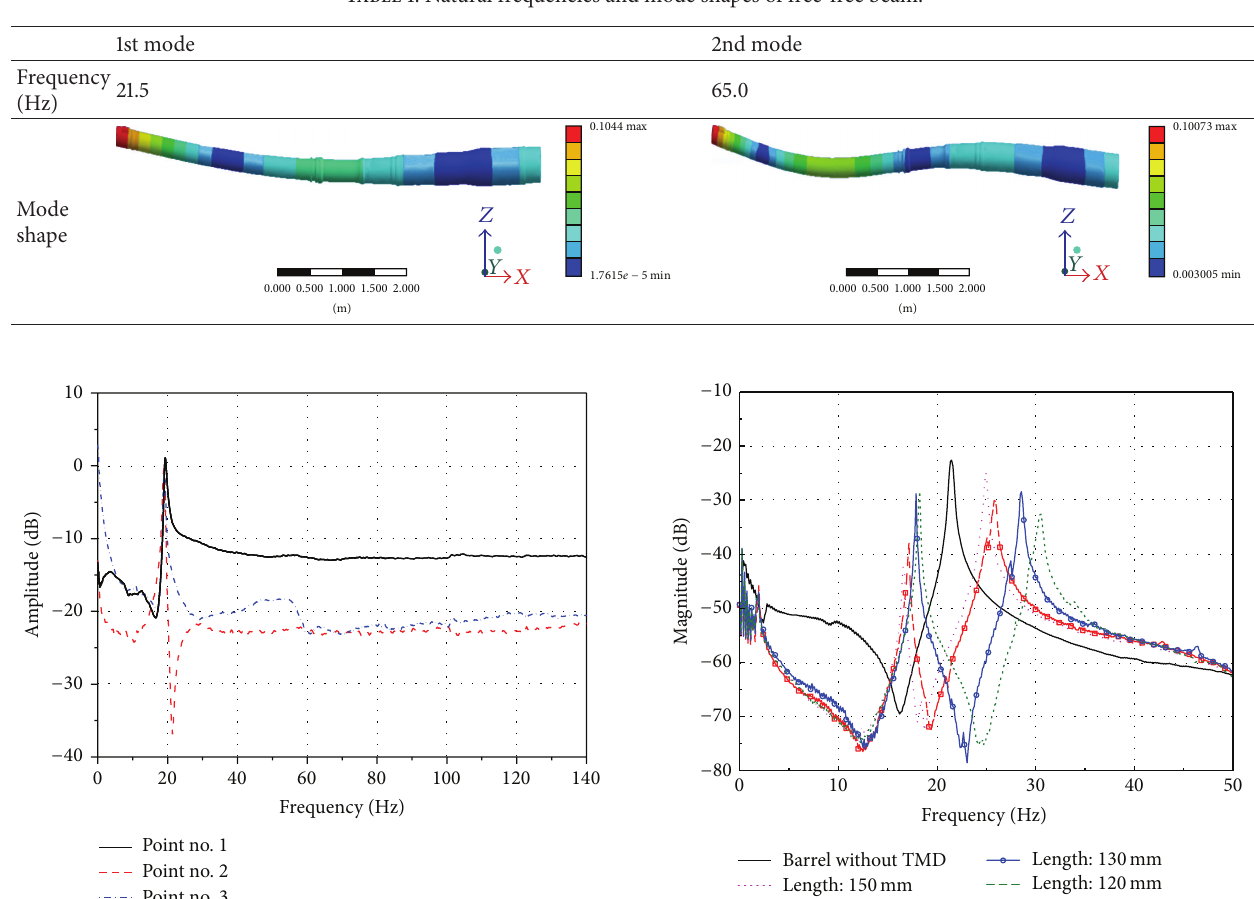
Table 1: Natural frequencies and mode shapes of free-free beam.